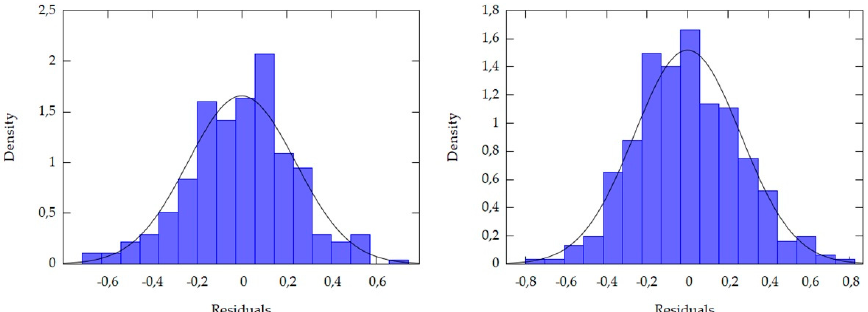
Figure 4. Normal distribution of the residuals for the model with ERBs ( left panel) and the model with EPI ( right panel).